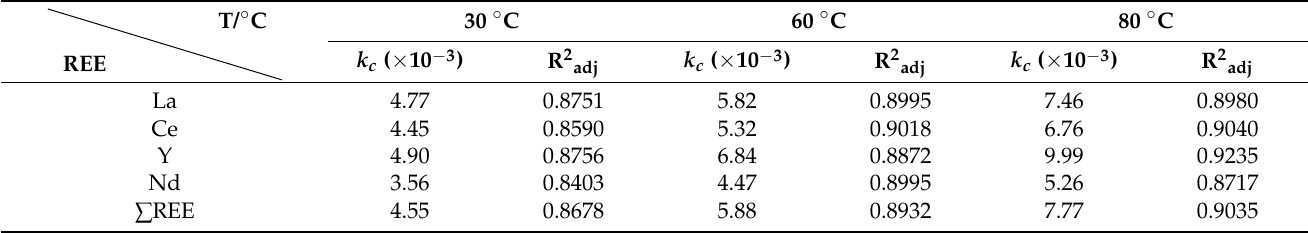
Table 3. k c and R 2 adj for the SCM of chemical reaction control based on spherical